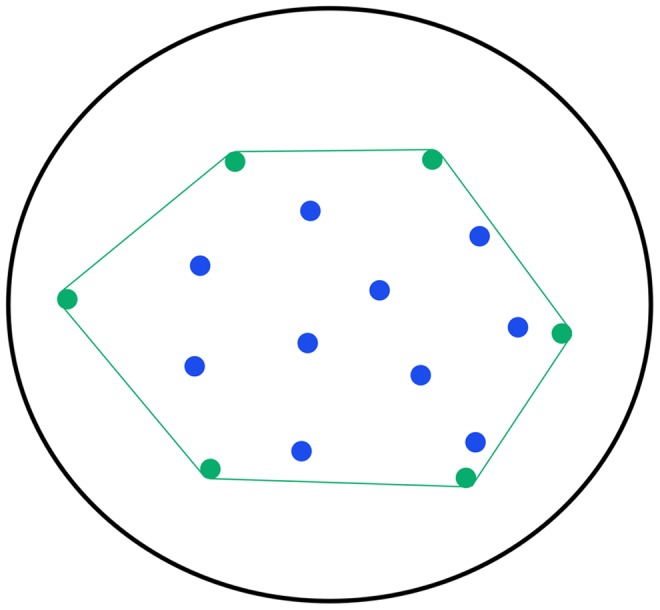
Simplified example of the convex hulling process.Black ellipse represents the initial extent of a rubber band stretched to encompass all coloured points. Green polygon represents the convex hull defined by the rubber band ‘snapping to’ the green boundary points. The internal (blue) points lie within the convex hull and do not contribute to defining its maximum extent.